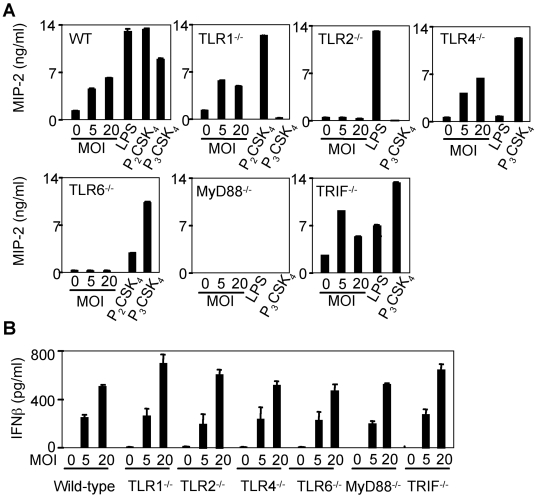
TLR2, TLR6 and MyD88 are critical for IFNβ-independent chemokine production after MVA infection.MIP-2 (A) and IFNβ (B) produced by wild-type, TLR1−/−, TLR2−/−, TLR4−/−, TLR6−/−, MyD88−/− and TRIF−/− bone marrow-derived macrophages infected with MVA (MOI 5 and 20) or stimulated with lipopolysaccharide (LPS, 100 ng/ml), Pam2CSK4 (P2CSK4, 10 µg/ml), Pam3CSK4 (P3CSK4, 10 µg/ml) for 24 h. Data are means±SD of triplicate samples from one experiment and are representative of 2 to 4 experiments.